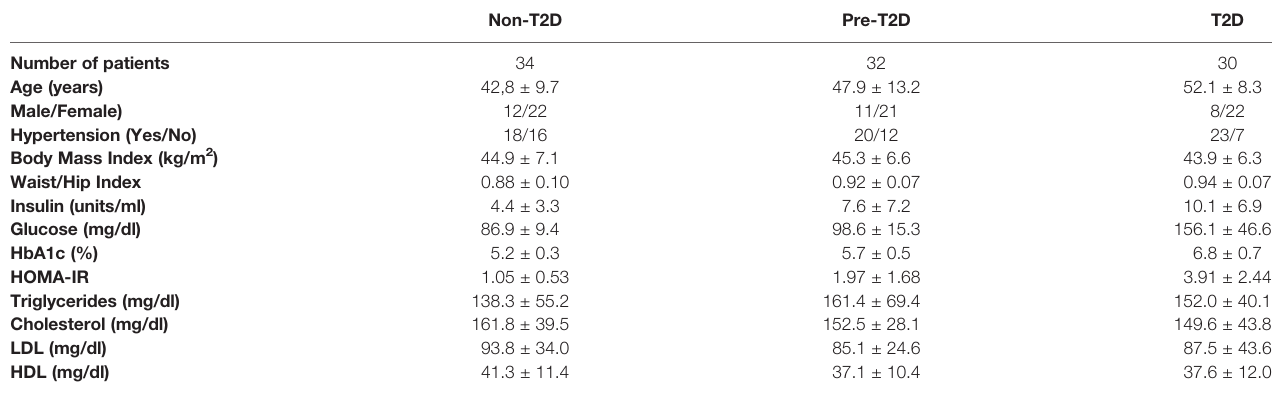
TABLE 1 | Cohort baseline